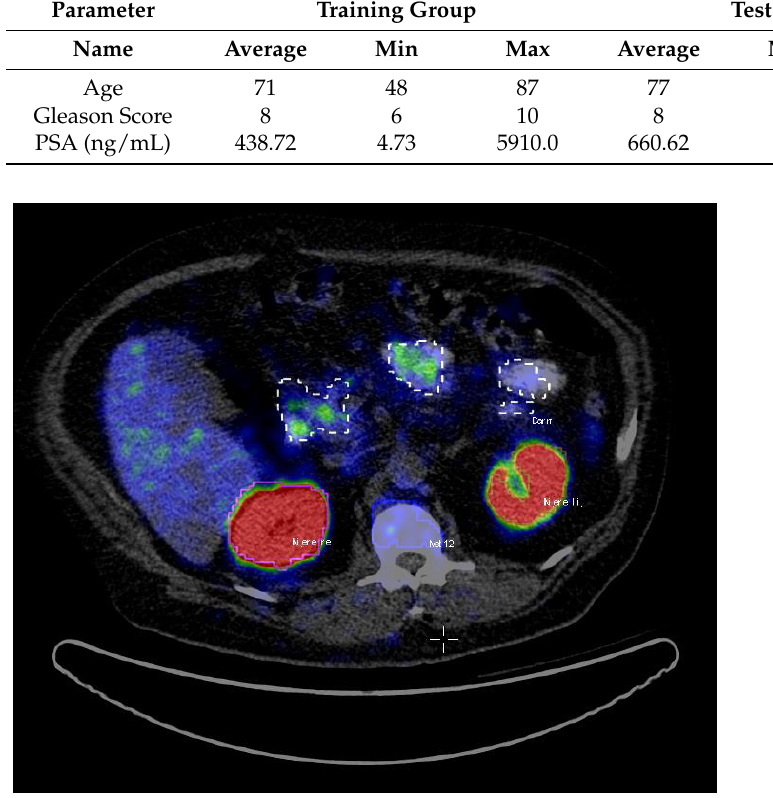
Figure 1. A sample screenshot from the hotspots’ delineation step using InterView Fusion Software (Mediso, Budapest, Hungary) [22]. The hotspots are identified and delineated slice by slice as 3D volumes of interests (VoIs) by an experienced nuclear medicine physician (the hotspot names trans- lation from German: Niere = kidney, Darm = gut. Moreover, Met stands for metastasis). Table 2. A list of the radiomics features from both positron emission tomography (PET) and computed tomography (CT) modalities. Please note that the metabolic tumor volume (MTV) is PET-specific. This table is already published in [20]. First or Higher Order Statistics